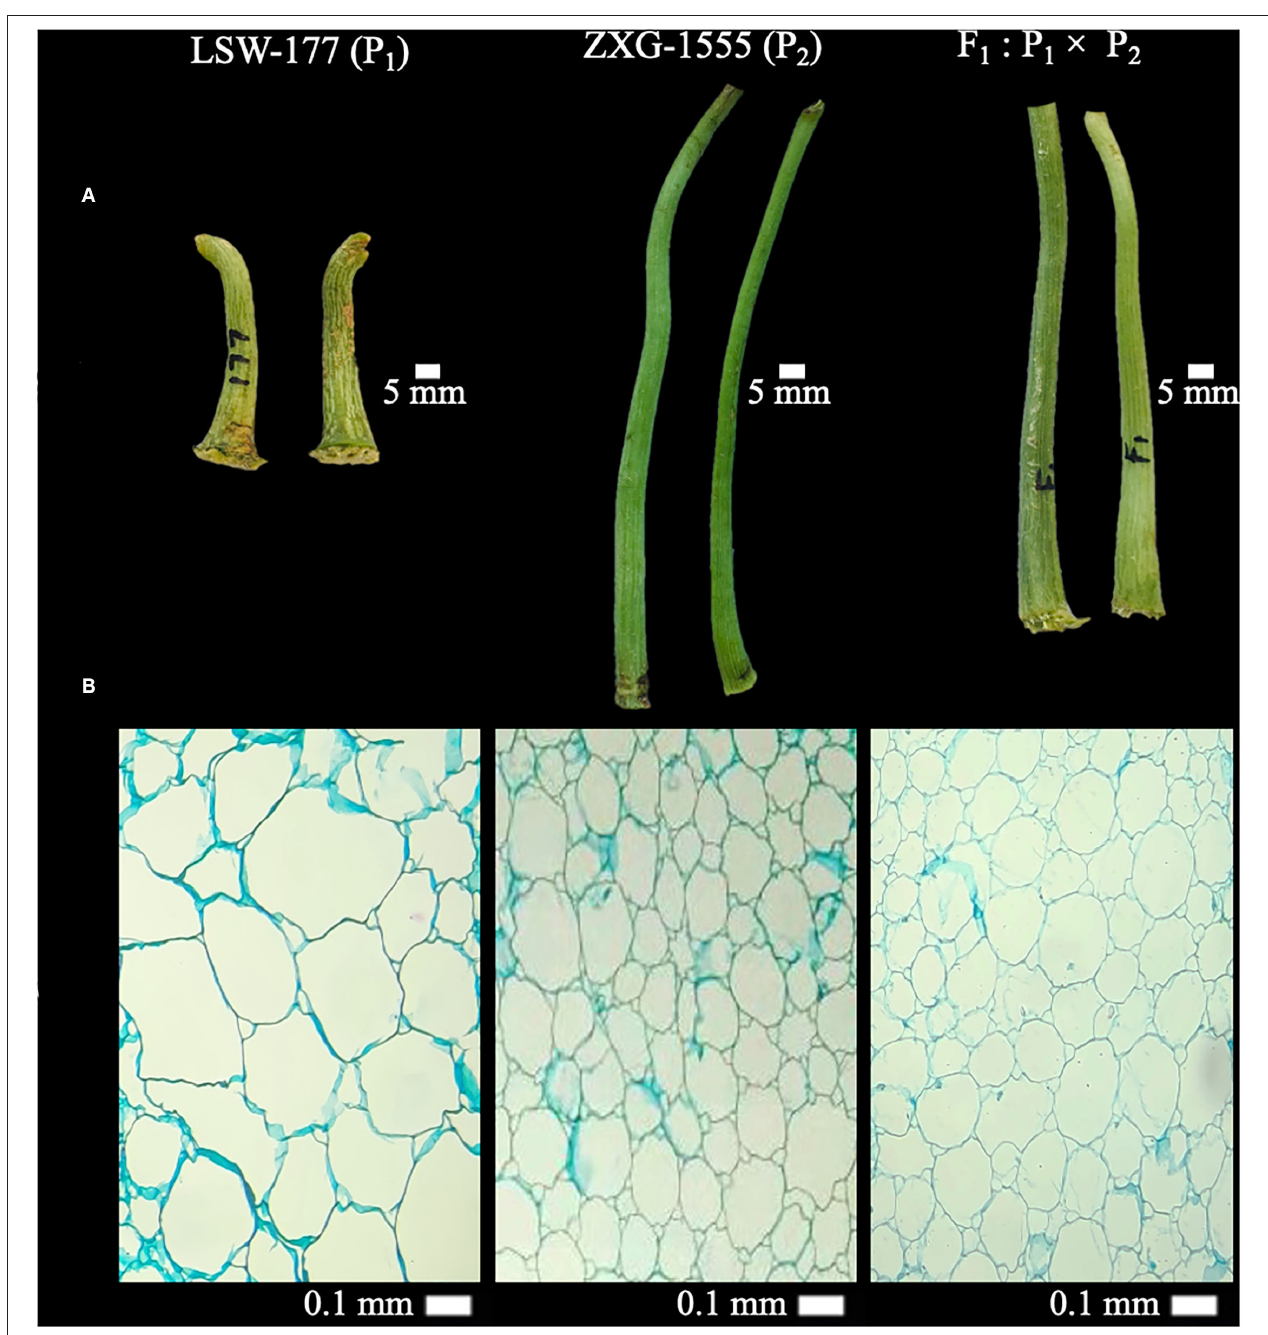
FIGURE 1 | Primary phenotypes and cytological observations of fruit pedicels (FP) of two watermelon parent lines and F 1 progeny. (A) Phenotypic observations at 5mm scale. (B) Cytological observations at 40 × magnification (0.1mm scale) of light microscope.